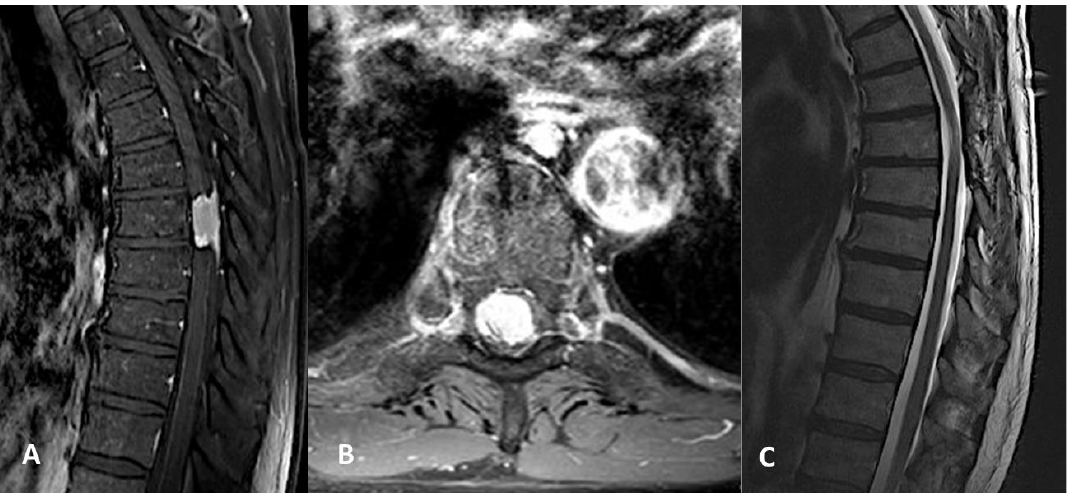
Figure 1. ( A ) Preoperative sagittal magnetic resonance image (MRI) showing a right thoracic spinal meningioma (SM) at level Th7. ( B ) Preoperative axial MRI showing the same SM. ( C ) Postoperative MRI demonstrating complete removal of the lesion.